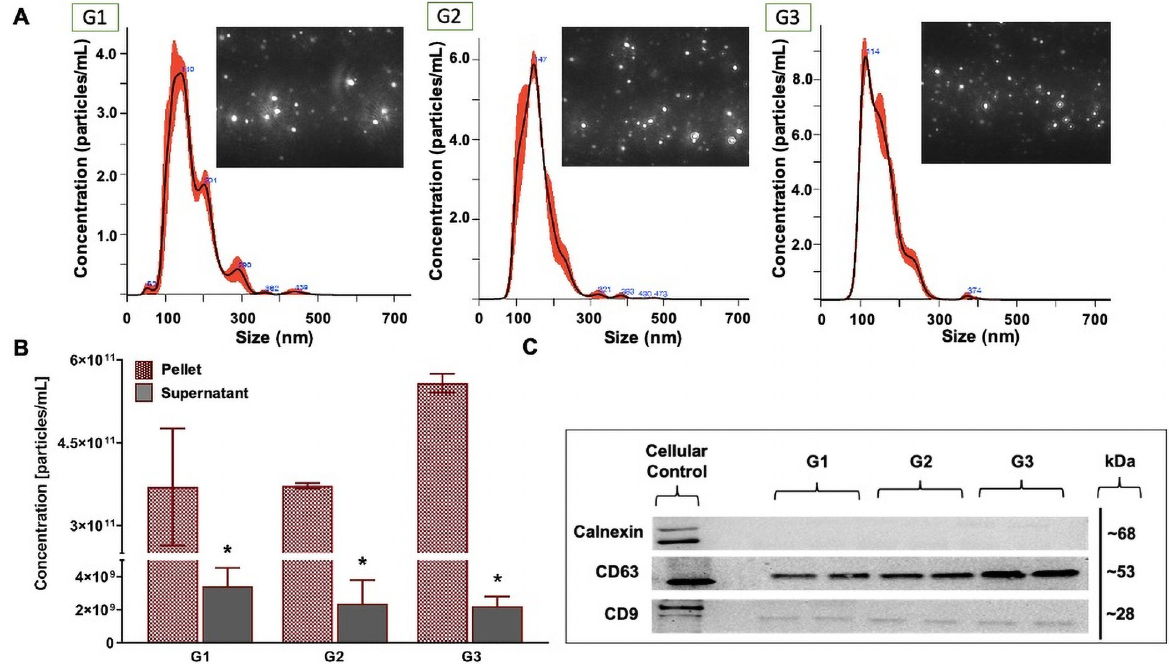
Fig 4. The effect of milk pre-processing prior to long-term storage for bovine milk-derived exosomes isolated via ExoQuick precipitation. Group (G)1: whole milk frozen immediately upon collection and processed post-thaw. G2: Whole milk processed to remove fat globules and cream prior to ultracold storage. G3: Whole milk processed to remove fat globules, cream, milk cells, and casein proteins prior to ultracold storage. Size and distribution profiles of bovine milk-derived exosomes as determined by Nanoparticle Tracking Analysis (NTA) (A). Concentration [particles/ mL] of bovine milk-derived exosomes (B). Relative protein abundance of two exosome-specific markers (CD9 and CD63) and a cellular marker (Calnexin) as determined by western immunoblotting (C). Total soluble protein isolated from human microglia cell culture (HMC3) is used to represent cellular protein profiles. Data are mean ± SEM with n = 2 independent trials/group. � Significant difference in exosome concentration between the pellets and supernatants (p � 0.05).